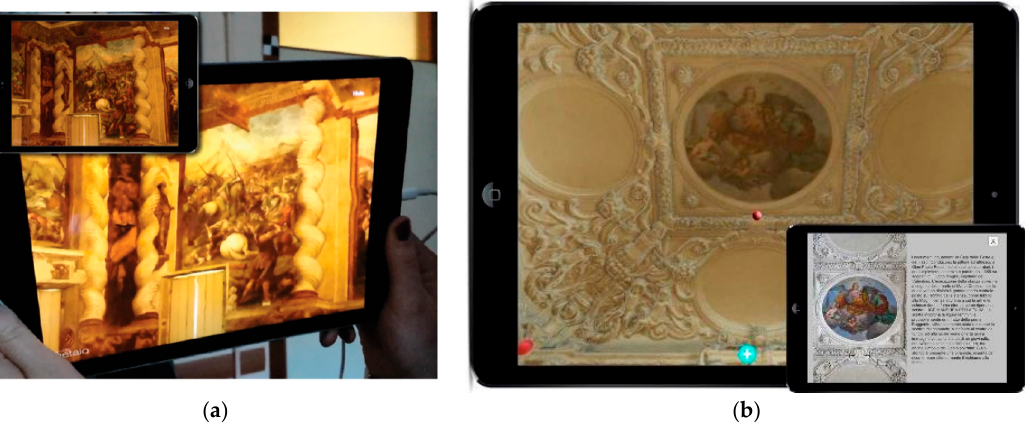
Figure 23. ( a ) The SLAM for full six-dimensional virtual reality/augmented reality (6D VR/AR) application running on an iPad; ( b ) Interactive model of the hall showing typical points enabling to reach additional information.